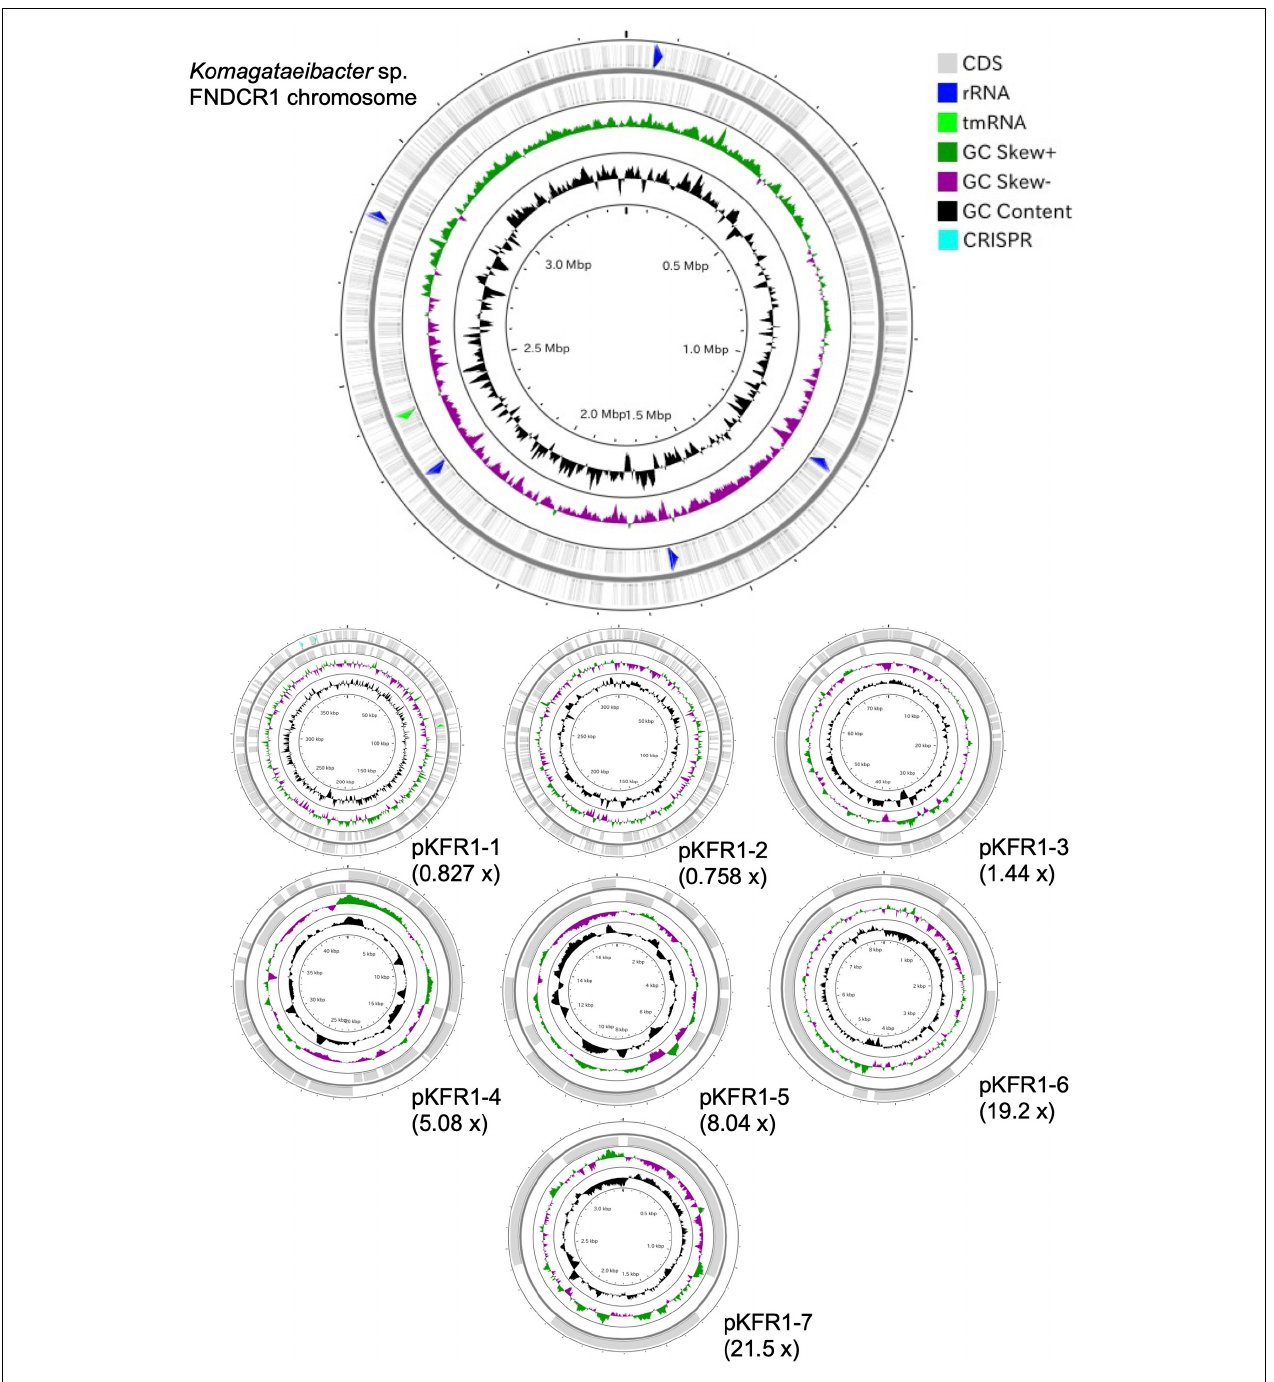
FIGURE 2 | Genome structure of the FNDCF1 strain. One circular chromosome and seven putative plasmids (pKFR1-1, pKFR1-2, pKFR1-3, pKFR1-4, pKFR1-5, pKFR1-6, and pKFR1-7) are shown. The value presented in parentheses represents the sequencing coverage of a plasmid relative to that of chromosome. Smaller contigs below 5,000 bp and non-circularized contigs are not shown in this